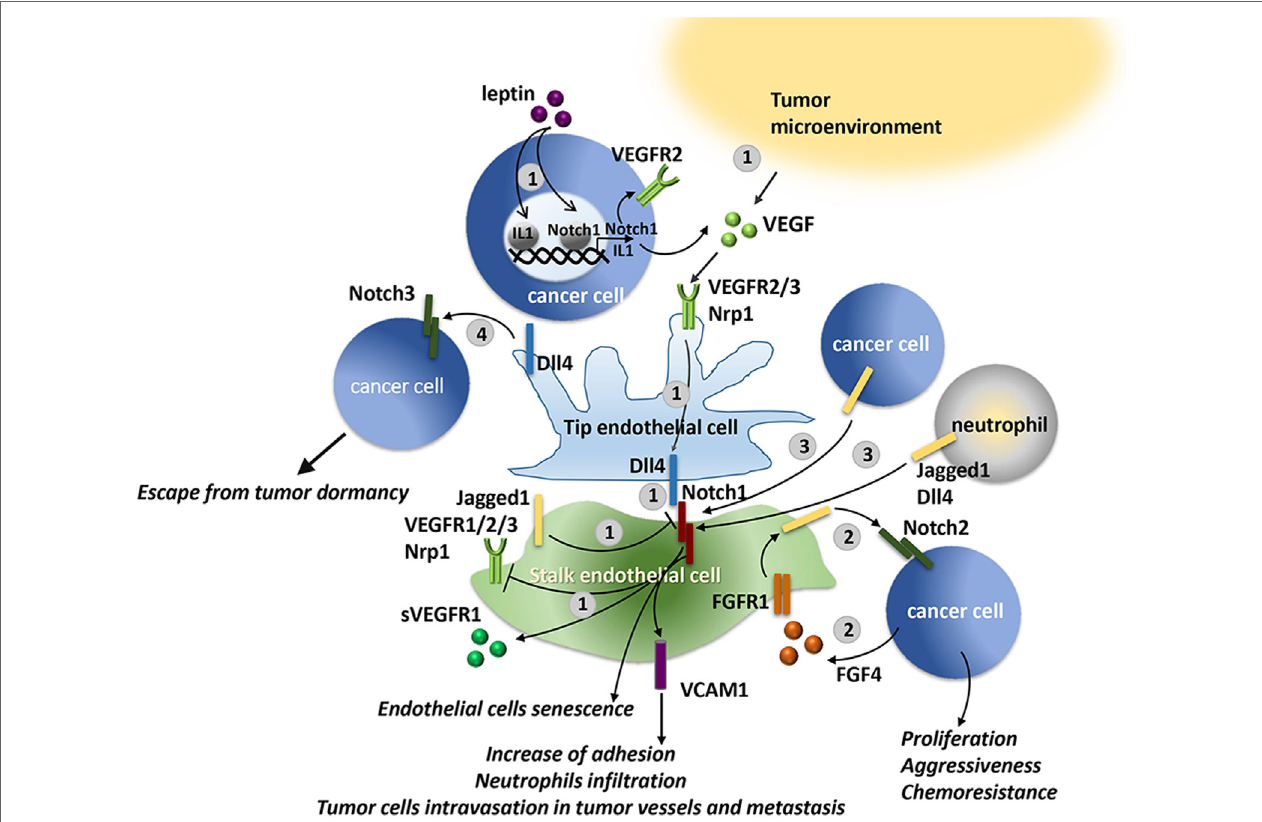
FiGURe 5 | VEGF and Notch interaction in physiological and tumor angiogenesis. Notch controls tip/stalk endothelial cells balance in tight cooperation with VEGF. 1. VEGF may be produced by cancer cells, for example, in breast cancer cells, leptin through IL-1 and Notch1, induces VEGF/VEGFR-2 upregulation (190), or by the neighboring cells of the tumor microenvironment (TME). VEGF engages VEGFR2/3 and neuropilin 1 (Nrp1) receptors on endothelial cells, activating a signaling that promotes Dll4 expression and determines the differentiation toward a tip cell type. Dll4 expressed on tip cells triggers Notch signaling in the neighboring cells suppressing the tip cell phenotype and inducing the differentiation in stalk cell. Notch activation in stalk cells either decreases VEGFR1/2/3 expression or stimulates antiangiogenic soluble splice variant of VEGFR1 (sVEGFR1) leading to a reduced sensitivity to VEGF (213). Oppositely to Dll4, Jagged1 expressed by stalk cells antagonizes Dll4-mediated Notch signaling in stalk cells, thereby increasing tip cell number and sprouting (214). 2. B-cell lymphoma cells release FGF4 that engages FGFR1 on the endothelial cells. FGFR1 activation induces Jagged1 upregulation that, in turn, triggers Notch2 signaling in lymphoma cells promoting their proliferation, tumor aggressiveness, and chemoresistance (215). 3. Notch1 signaling in endothelial cells may be activated by tumor-derived ligands, i.e., Jagged1 and Dll4 expressed by lung carcinoma and melanoma cells, or by Jagged1 expressed by neutrophils. Notch1 activation promotes endothelial cell senescence and expression of the adhesion molecule, VCAM1, that promotes neutrophil infiltration and tumor cell metastasis (216). 4. In models of tumor dormancy of colorectal carcinoma and T cell acute lymphoblastic leukemia (T-ALL) it was shown that Dll4 expressed on tumor endothelial cells can trigger Notch3 pathway activation in tumor cells conferring tumorigenic properties to the dormant cells